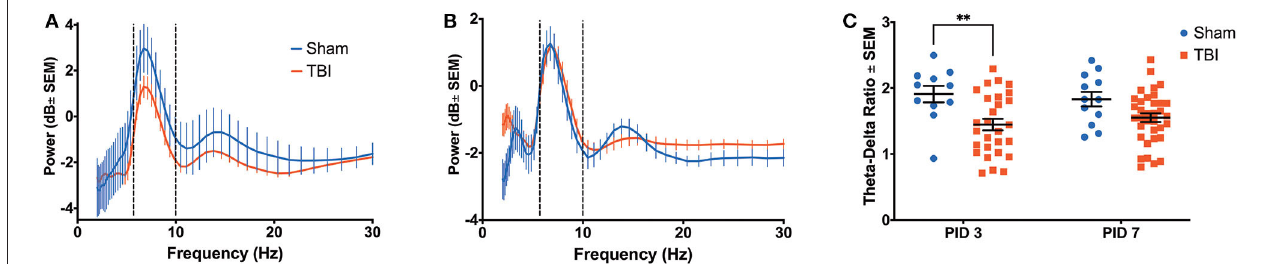
FIGURE 3 | Hippocampal Recovery Following Injury. A three-way ANOVA identified a significant effect of power ( p < 0.001), time ( p < 0.001) and group ( p < 0.001) on theta oscillatory power over the first week post-injury. Dashed lines highlight the theta range (6–10Hz). (A) A power spectral density from the hippocampus on PID3 reveals lower theta power in injured animals compared to shams. (B) By PID7, hippocampal theta power had returned to sham-like levels. (C) There was a primary effect of group on TDR over time ( p < 0.01), but post-hoc analysis revealed that the two groups only significantly differed on PID3. All data are presented as mean ± SEM, ** p < 0.01. Adapted from Paxinos et al. (51).